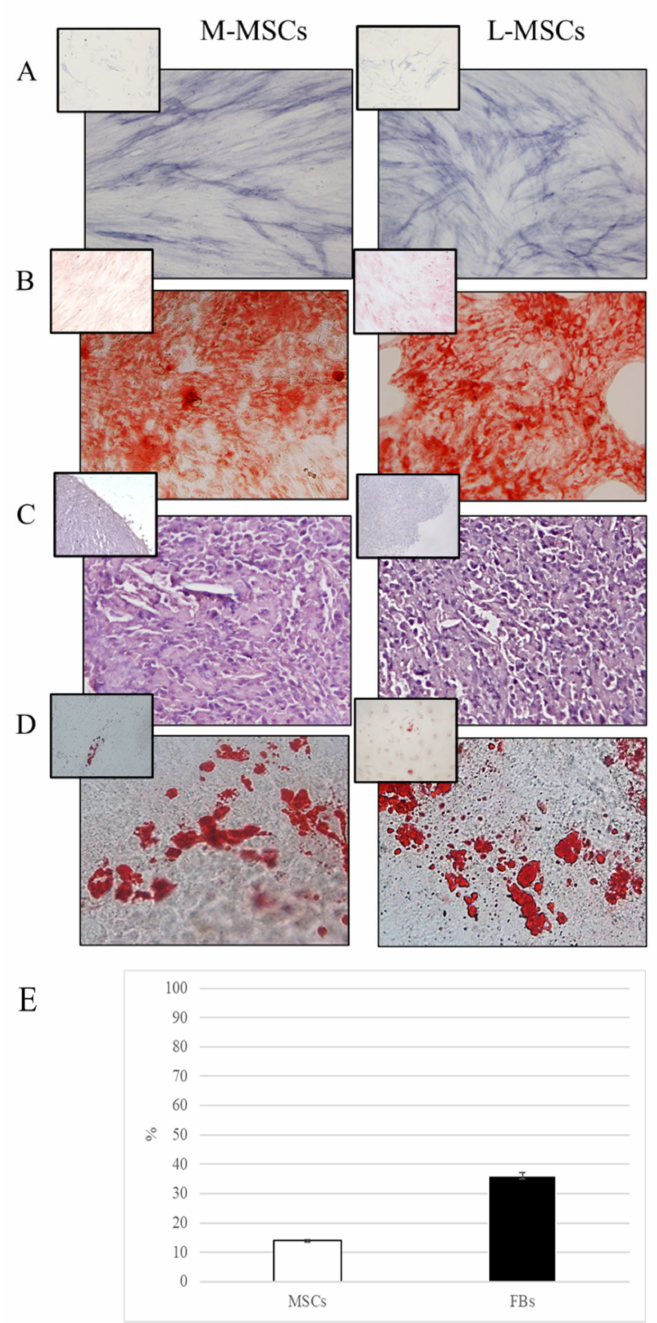
Figure 2. Multilineage differentiation of MSCs from myometrium (M-MSCs) and leiomyoma (L-MSCs) and relative fibroblasts (in the inserts). Representative images of osteogenic differen- tiation assessment by ALP reaction ( A ) and Alizarin red staining ( B ); chondrogenic differentiation by Safranin-O staining ( C ); adipocyte differentiation by Oil red staining ( D ). Percentage of CD9 positive cells after flow cytometric analysis (E). Data are presented as mean ± SD of the 12 samples of L- and M-MSCs and related